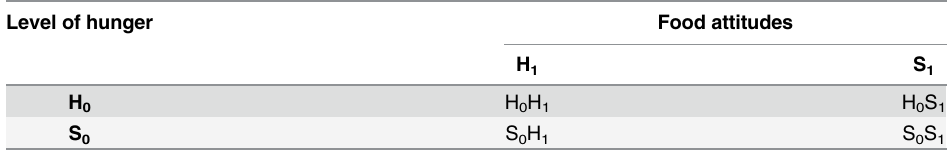
Table 1. Experimental